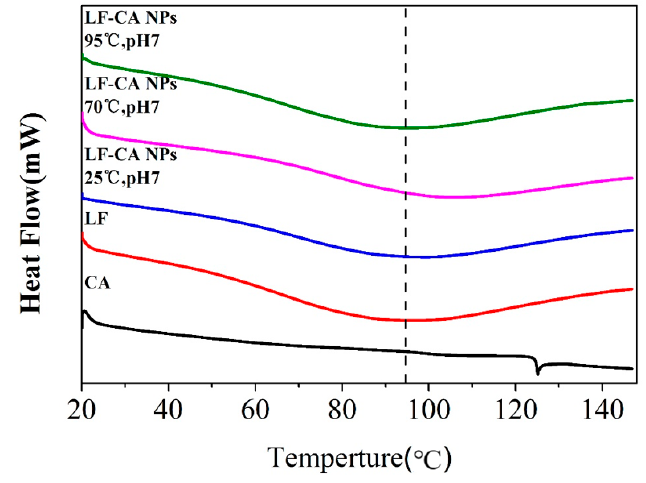
Figure 7. DSC of LF-CA NPs, LF NPs, and CA.